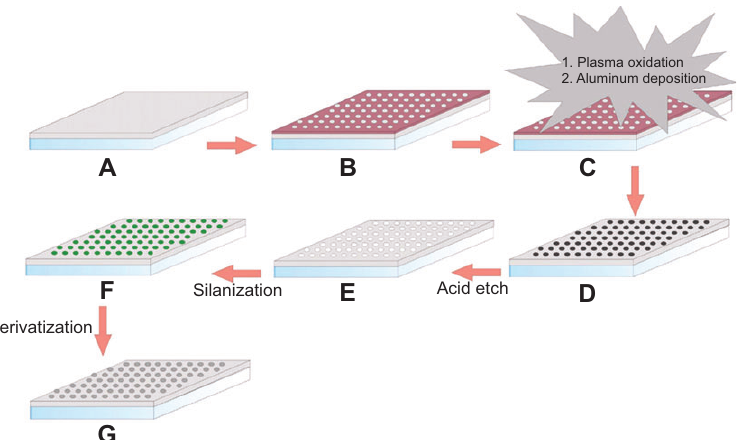
Figure 3 Diagram of the functionalization of the PDMS array. (A) Glass slide spin-coated with a thin PDMS layer. (B) PDMS substrate covered with stainless steel mesh. (C) Substrate exposed to argon plasma followed by aluminum deposition. (D) Mesh removal revealing an array of aluminum circles. (E) Phosphoric acid etch revealing oxidized surface. (F) Silanization to achieve desired surface functionality. (G) Derivatization with fluorescent molecule ( S é guin et al. 2010 ).